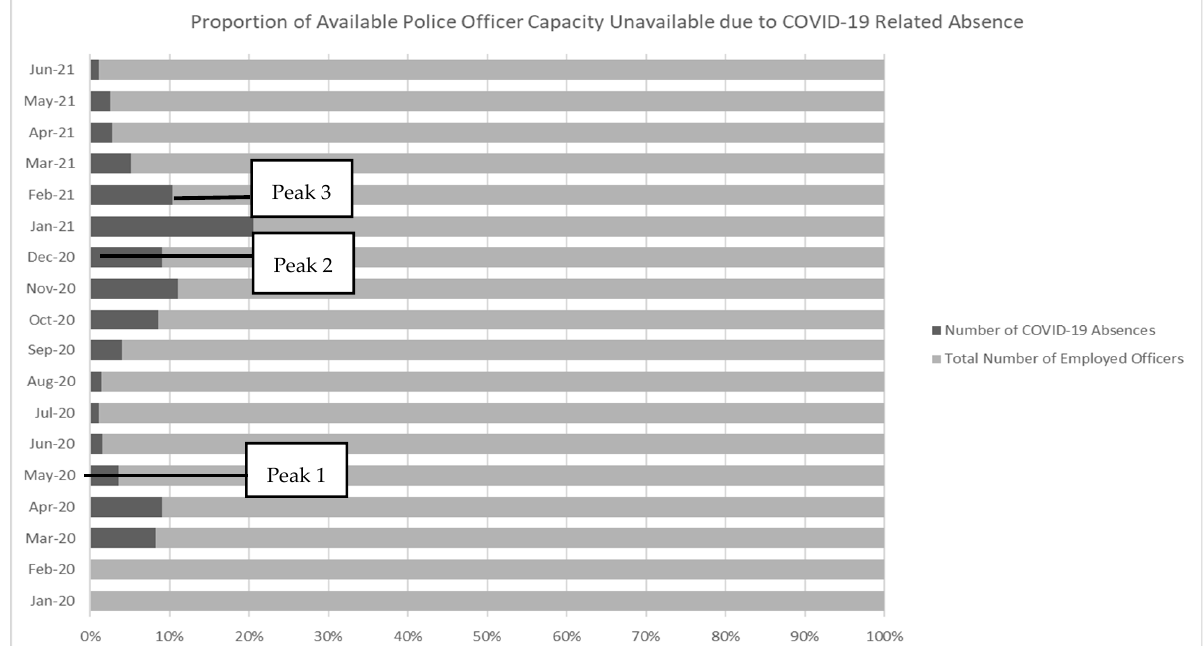
Figure 1. Overall impact of COVID-19 on available police officer capacity by month.